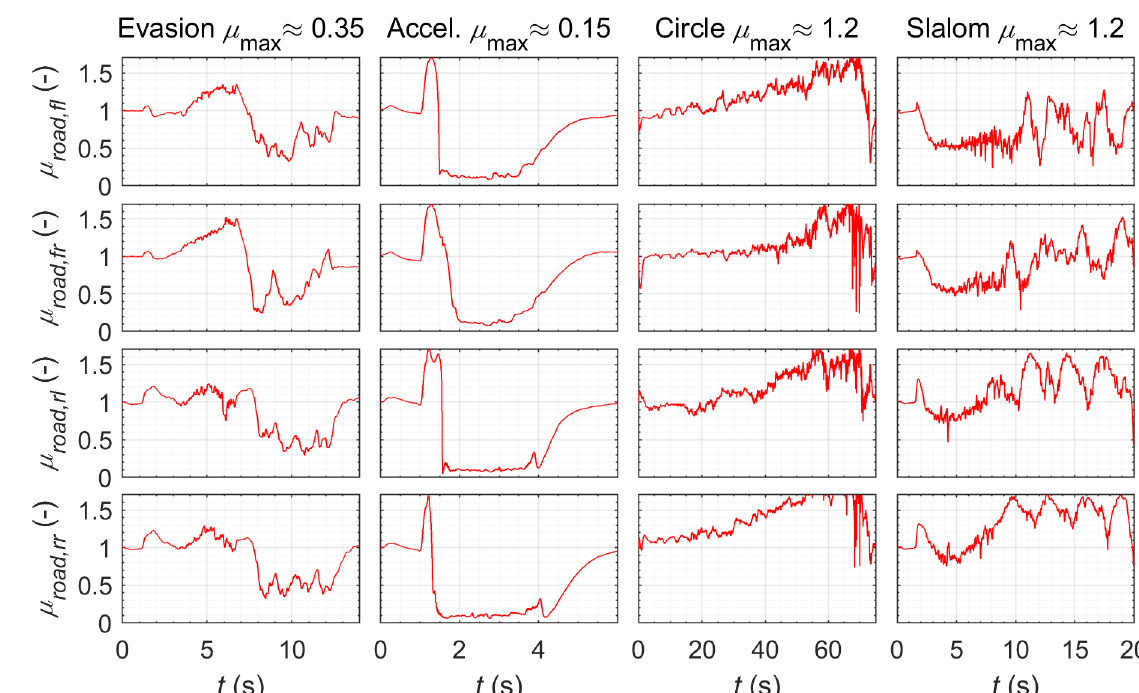
Figure A7. Test data: estimated unknown friction